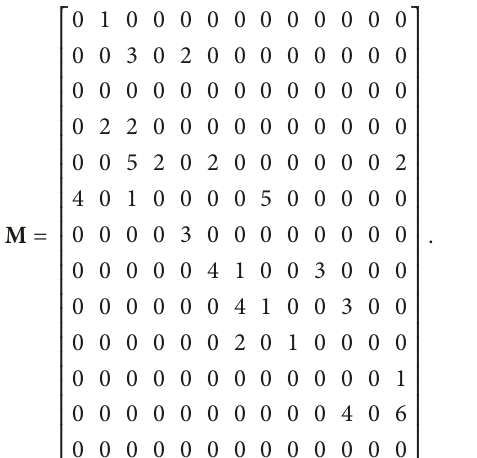
node. For realizations of random networks, the